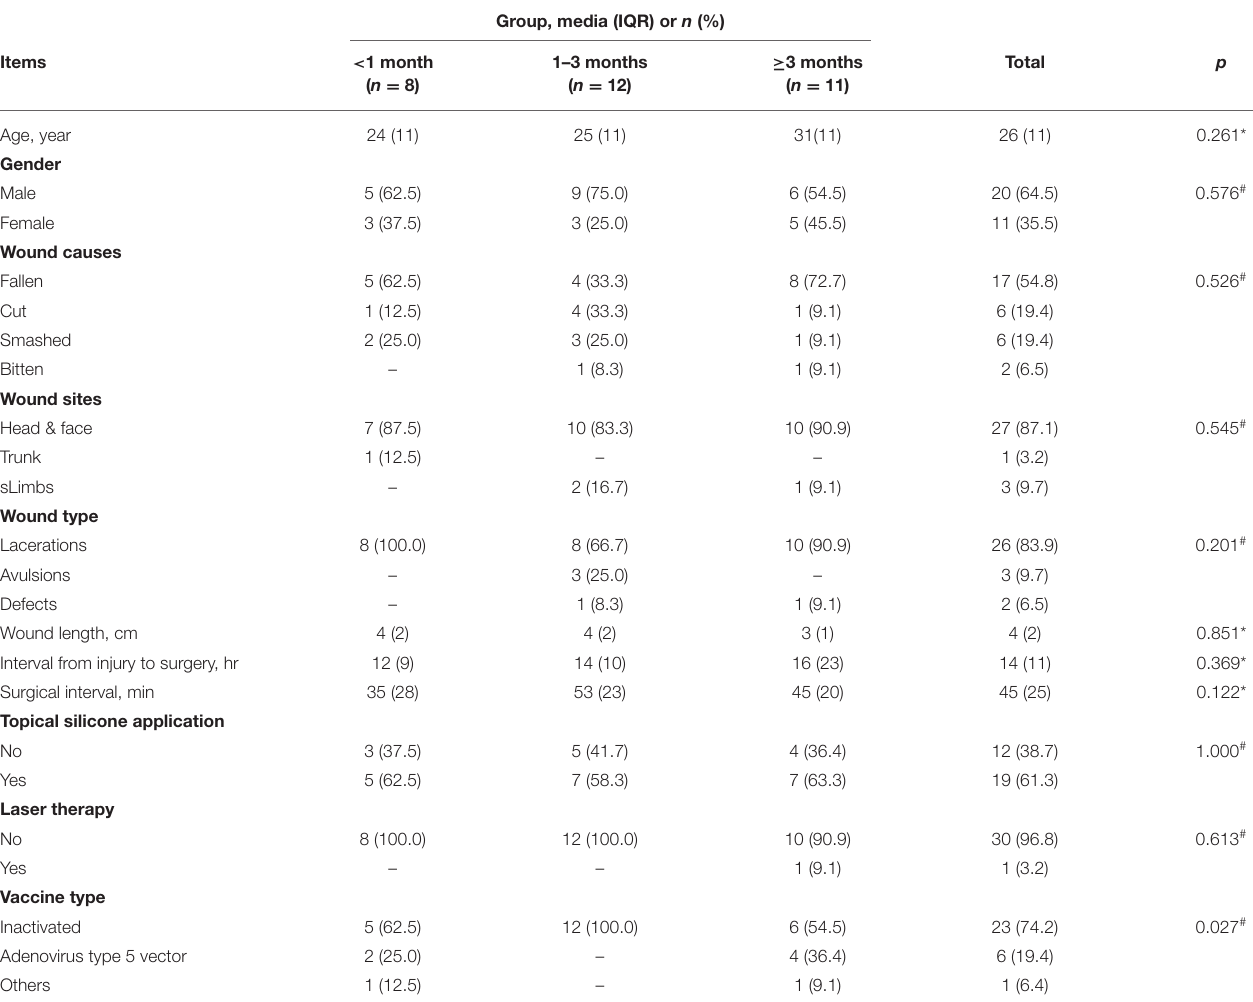
TABLE 1 | Patient